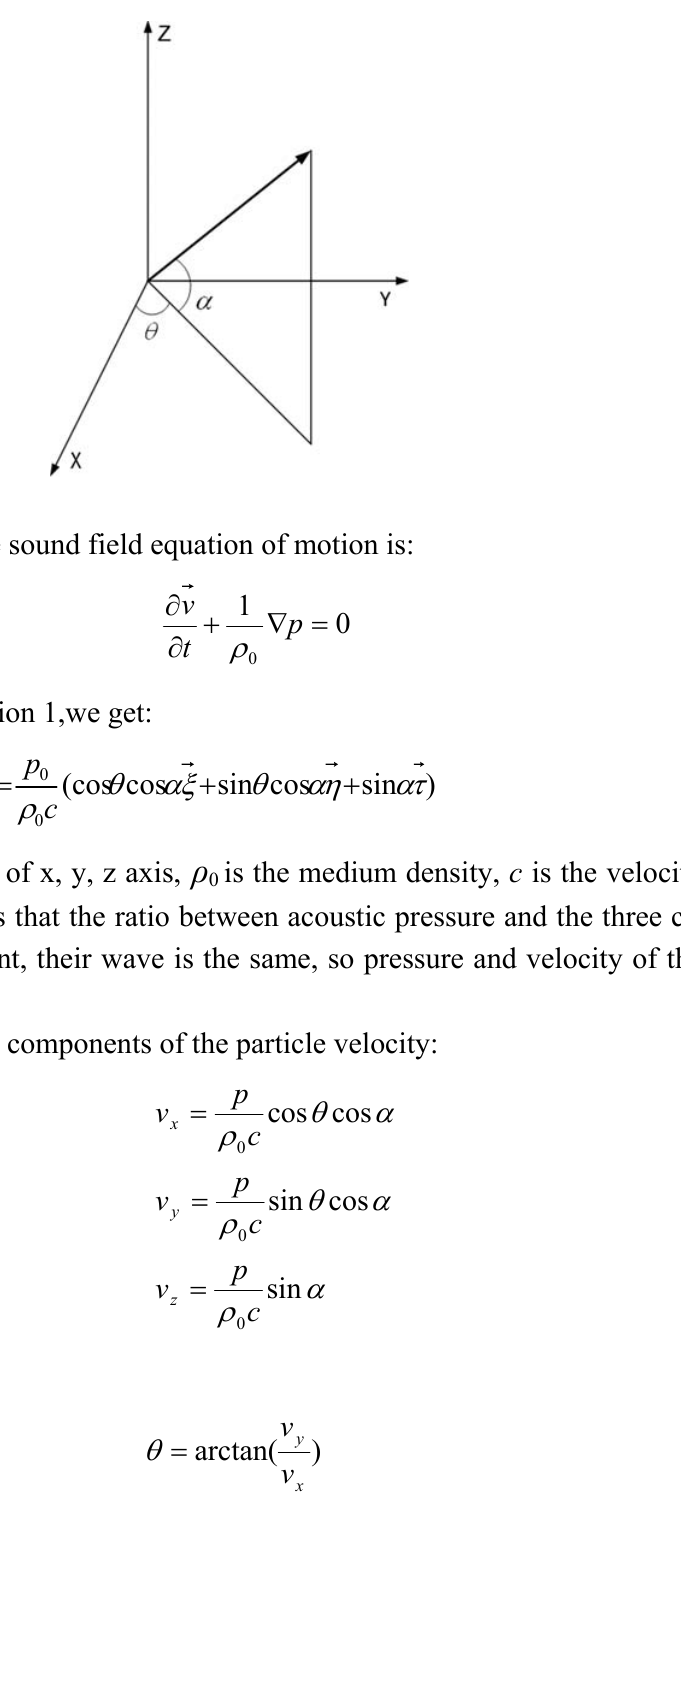
Figure 4. Wave vector’s projection in the coordinate